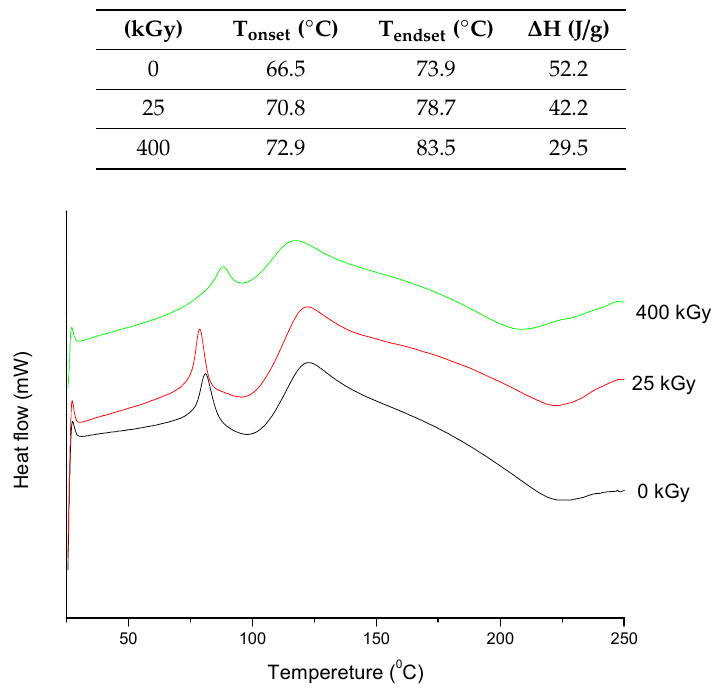
Figure 5. Differential scanning calorimetry (DSC) curves of non-irradiated and irradiated (25 and 400 kGy) ERP.